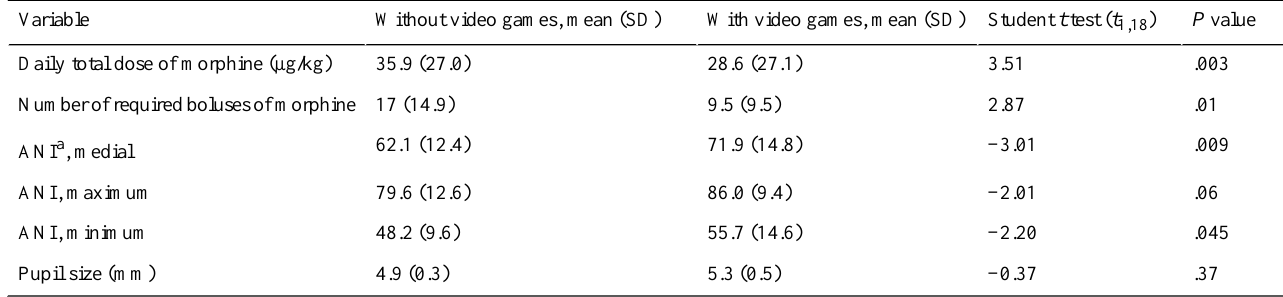
Table 1. Parameters of the patient-controlled analgesia pump, Analgesia Nociception Index monitor, and AlgiScan monitor on treatment days.